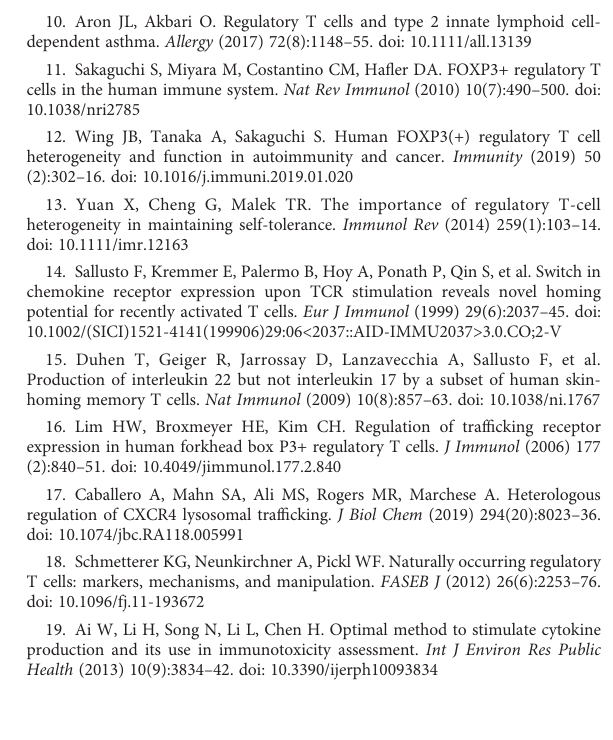
Treg (n=5) and (B) Tconv cells (n=5). Data are presented as fl oating bars (min to max, the line indicates mean). SUPPLEMENTARY FIGURE 4 Identi fi cation of surface markers expressed mainly by Treg cells. (A) Adhesion or migratory molecules, (B) cytokine receptors, (C) markers with enzymatic activity, (D) molecules associated with the TCR complex, (E) activation markers, and (F) representative contour plots. Numbers adjacent to gates indicate the percent gated cells as positive for the given surface marker (blue – Treg, red – Tconv cells). To compare Treg and Tconv cells, plots were made by the concatenation function by FlowJo. Data are presented as bars (n=5, for both Treg and Tconv) and represent the mean ± SD. * P ≤ 0.05 and ** P ≤ 0.01 (Mann Whitney test (A – E) ). SUPPLEMENTARY FIGURE 5 Identi fi cation of surface markers expressed mainly by Tconv cells. (A) Co- inhibitory and co-stimulatory molecules, (B) chemokine receptors, (C) adhesion or migratory molecules, (D) cytokine receptors, (E) complement regulatory proteins, (F) membrane transporters, and G. markers with enzymatic activity. Data are presented as bars (n=5, for both Treg and Tconv cells) and represent the mean ± SD. * P ≤ 0.05 and ** P ≤ 0.01 (Mann Whitney test (A – E) ). SUPPLEMENTARY FIGURE 6 Representative contour plots. Contour plots showing the difference in expression surface markers shown in Supplementary Figure 5. Numbers adjacent to gates indicate the percent gated cells as positive for the given surface marker (blue – Treg, red – Tconv cells). To compare Treg and Tconv cells, plots were made by the concatenation function by FlowJo. SUPPLEMENTARY FIGURE 7 Distribution of selected surface markers on FOXP3 + T cells. (A) tSNE analysis (n =10/replicate) and the resulting plots and distribution of CD95, CD120b, TIGIT, CD39, CD137, and GITR on FOXP3 + T